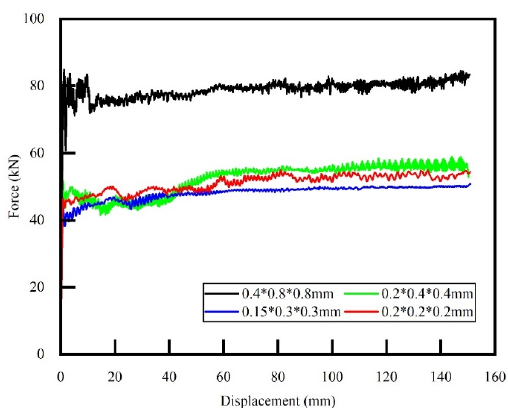
Figure 5. Force–displacement curves for different element